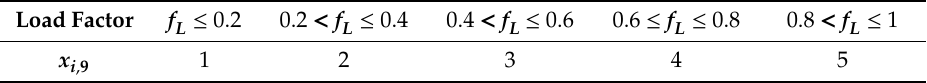
Table 9. Performance values x i ,9 for 9th criterion.